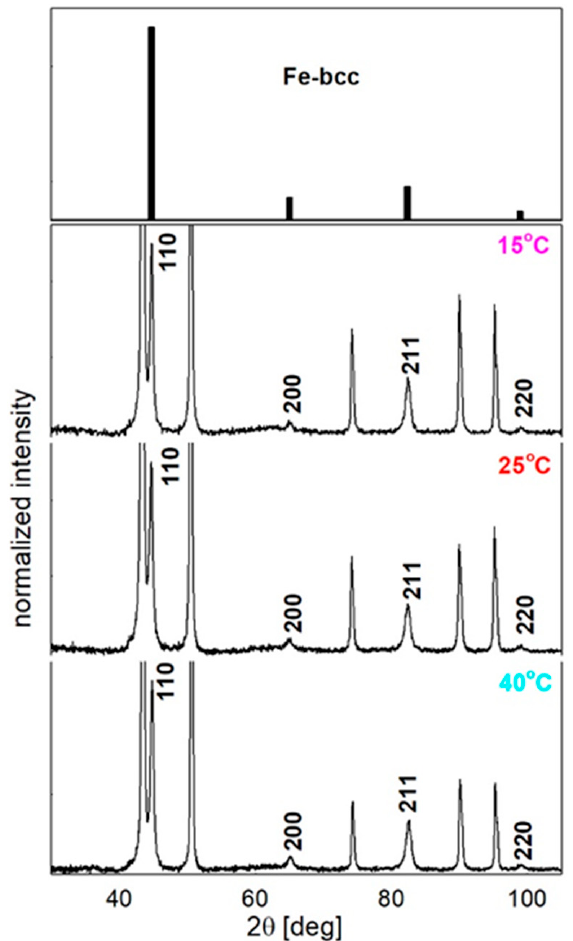
Figure 9. X-ray diffraction patterns measured for the Fe nanowires embedded in the polycarbonate membranes. The indexed peaks corresponded to the bcc Fe powder sample (reference code: 03-065-4899 NIST Database), while the peaks, which are not described, correspond to the copper contact layer.